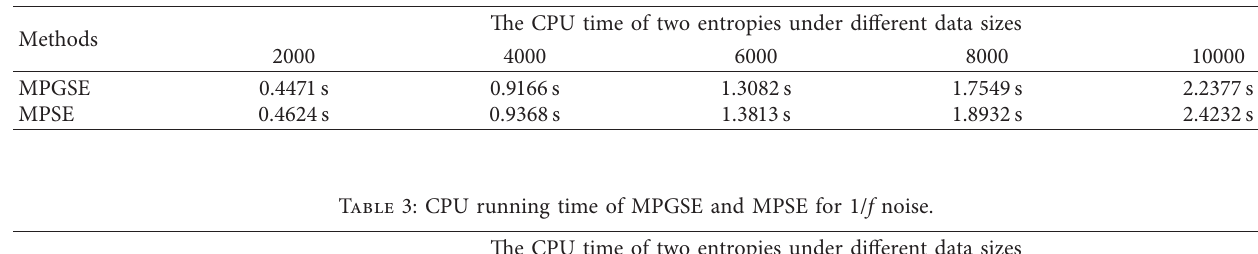
Figure 11: MPGSE and MPSE of the noise signal under different data sizes. (a) MPGSE of white noise, (b) MPSE of white noise, (c) MPGSE of 1/ f noise, and (d) MPSE of 1/ f noise. Table 2: CPU running time of MPGSE and MPSE for white noise.